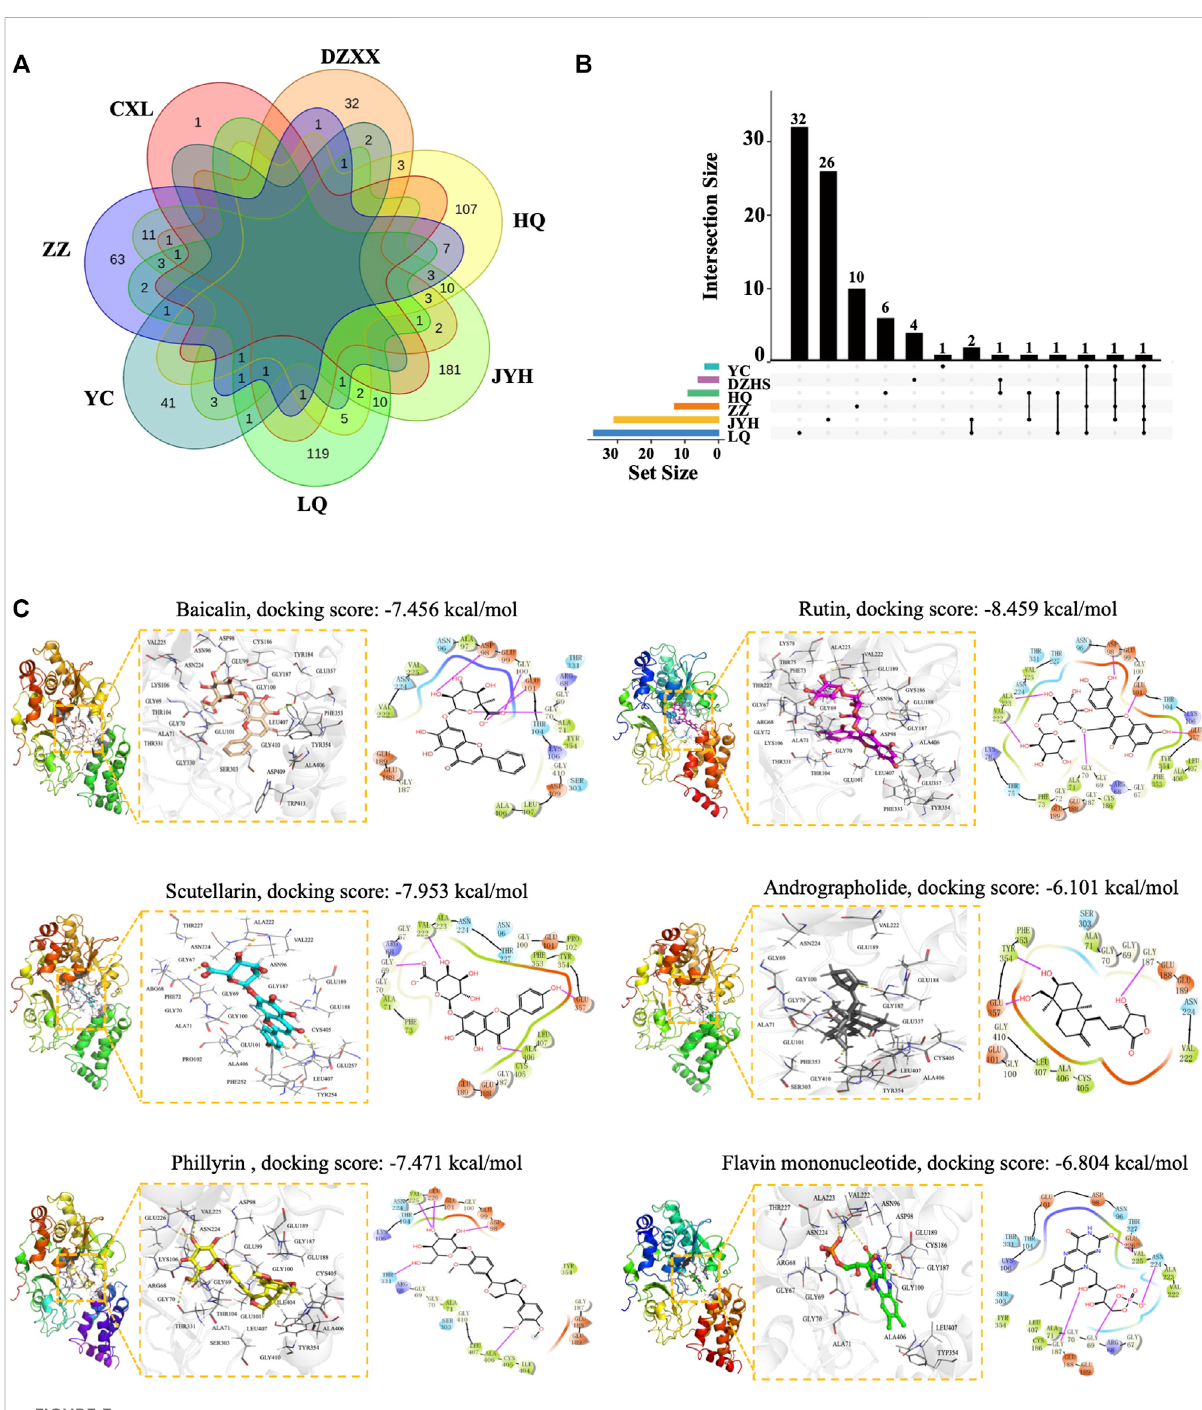
FIGURE 3 Identi fi cation of mitochondrial toxic ingredients by molecular docking. (A) Venn diagram of ingredients from Huangqin (HQ), Jinyinhua (JYH), Lianqiao (LQ), Yinchen (YC), Zhizi Dengzhanxixin (DZXX), and Chuanxinlian (CXL). (B) UpSetR plot of ingredients with a docking score below − 6.804. (C) MolecularmodesofthebindingofcompoundswithNDUFV1complexshownas3Dand2Ddiagrams.Thehydrogenbondisindicatedbyayellow dotted line (left) and the purple arrows represent hydrogen bond interactions between molecules. Baicalin, scutellarin, rutin, phillyrin, andrographolide, and the natural ligand fl avin mononucleotide are shown in orange, cyan, yellow, magenta, gray, and green sticks respectively, and key residues are shown as a line in white